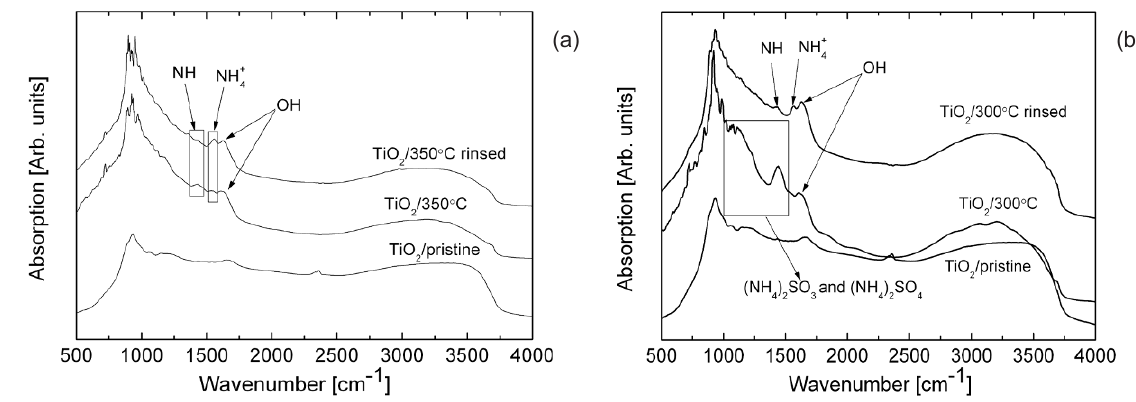
Figure 3. The FTIR/DR spectra of studied samples: a) [TiO